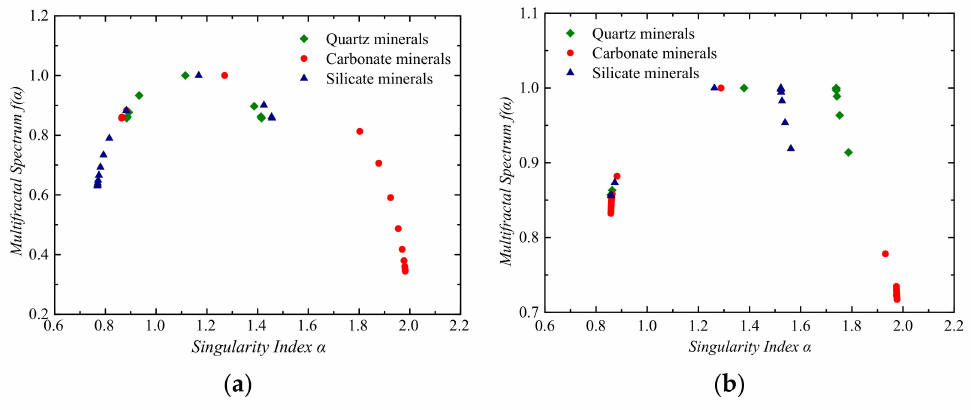
Figure 7. Multifractal singular spectral function. ( a ) Undisturbed loess; ( b ) Lime-treated loess. Symmetry ∆ f = f ( α min ) − f ( α max ) reflects the shape characteristics of multifractal spectrum function. When ∆ f < 0, f ( α ) was in the form of a right hook; when ∆ f > 0, f ( α ) was in the form of a left hook [19]. From Figure 7, it can be seen that in undisturbed loess, the ∆ f of quartz mineral particles equaled 0 with a uniformly symmetrical shape, whereas the carbonate mineral particles ∆ f > 0, f ( α ) showed a left hook, and feldspar mineral particles ∆ f < 0, f ( α ) showed a right hook. In the lime-treated loess, quarts and feldspar mineral particles ∆ f < 0, f ( α ) was in the form of a right hook, whereas carbonate mineral particles ∆ f > 0, f ( α ) showed a left hook. Except the uniform symmetry of the quartz particles α − α ( q ) in the undisturbed loess, the other two mineral particles α − α ( q ) and the quartz, carbonate, and feldspar mineral particles α − α ( q ) in the lime-treated loess were content of the mineral particles changes with the particle